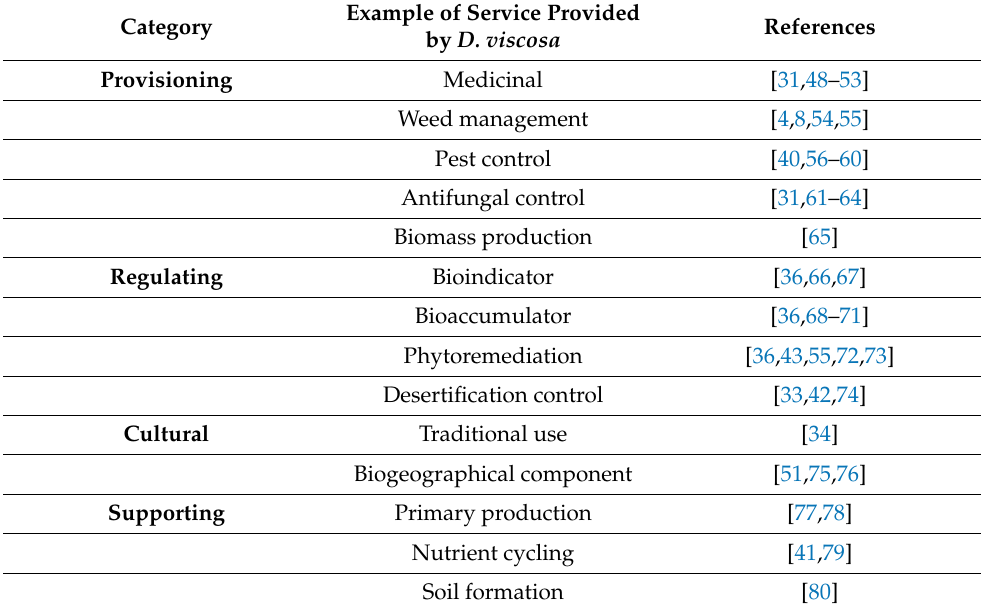
Table 1. Ecosystem services, as defined by the Millennium Ecosystem Assessment [24], provided by Dittrichia viscosa . Example of Service Provided Category by D.